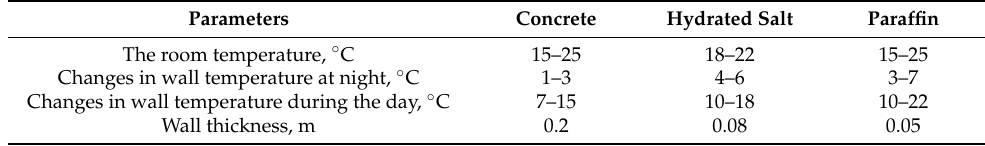
Table 1. Comparison of wall characteristics.